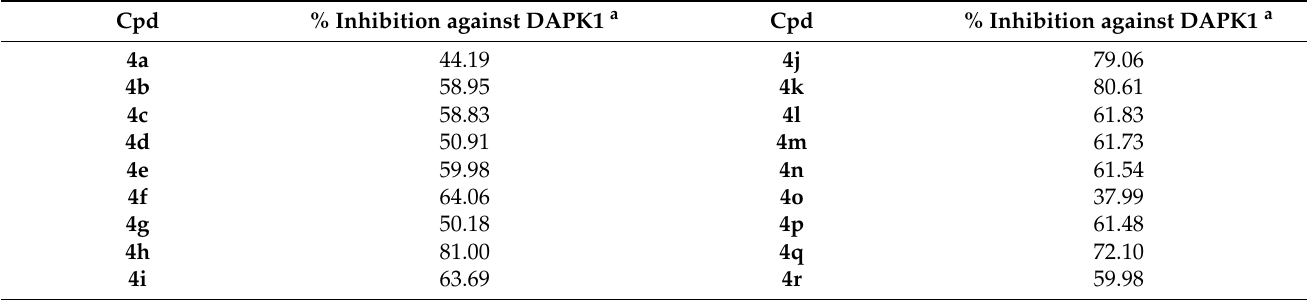
Table 3. DAPK1 kinase % inhibition activity for the final target compounds 4a ‒ r at 10 µM.